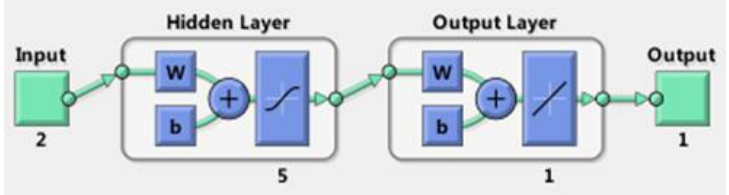
Figure 10. The structure of the BP neural network.